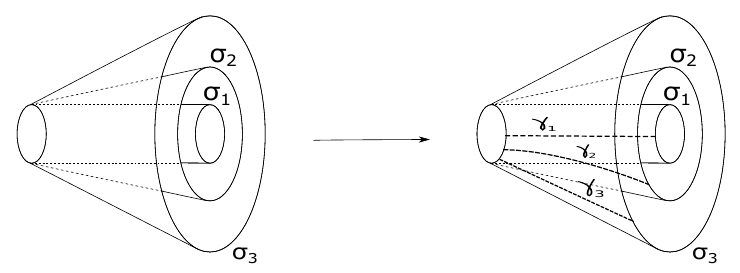
Figure 4 . S n TFT2 for Kronecker coe(cid:14)cients: permutation basis.